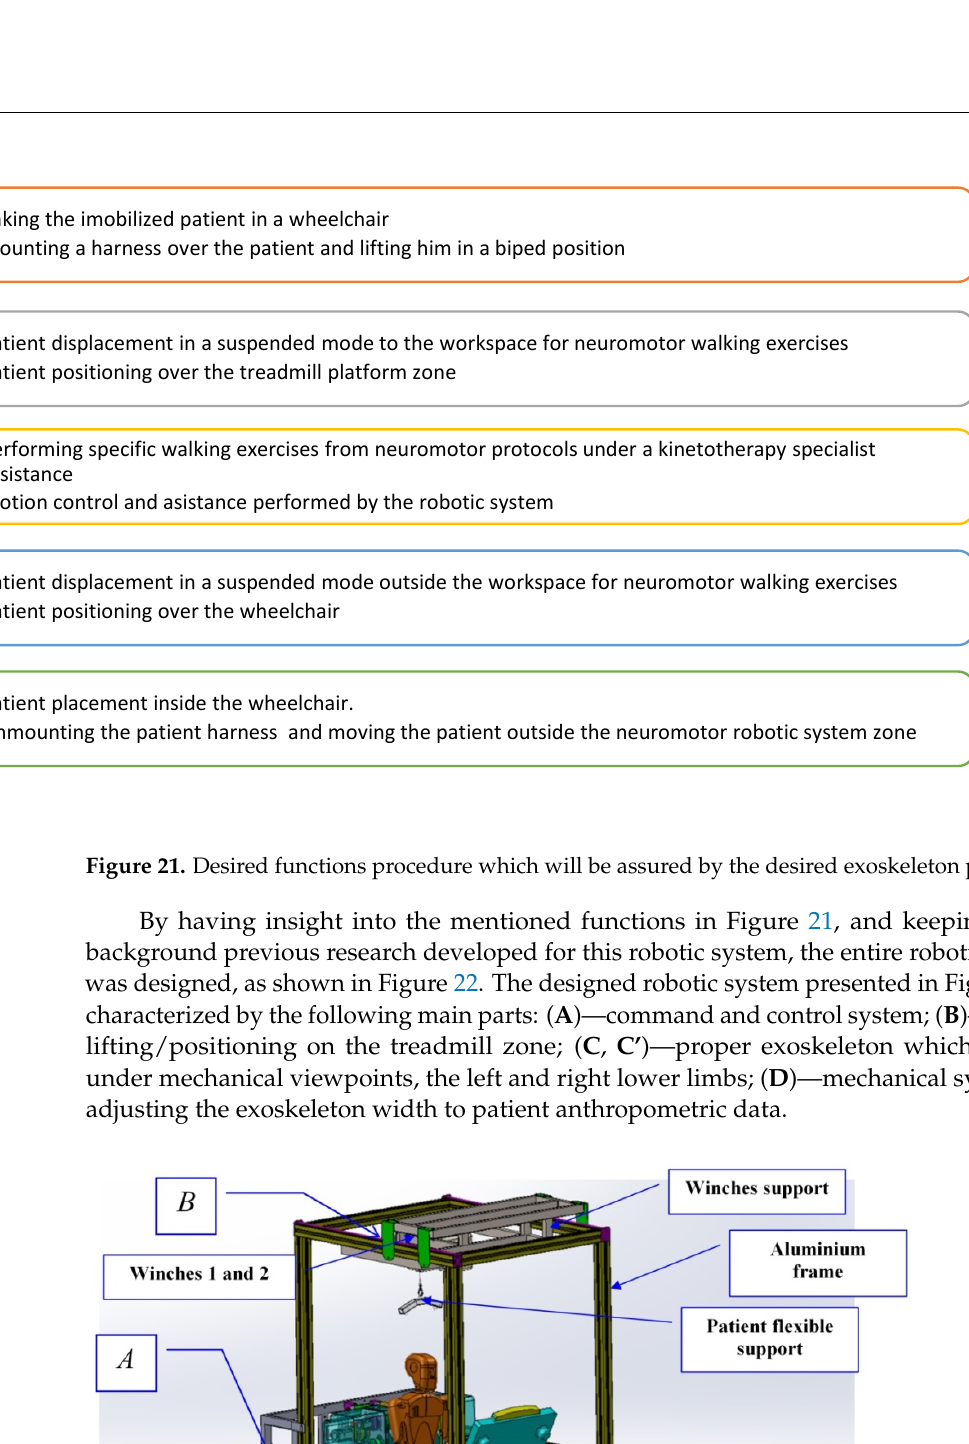
( b ) Figure 23. Markers’ positions for the exoskeleton prototype experimental tests: ( a )—right lower limb; ( b )—left lower limb.